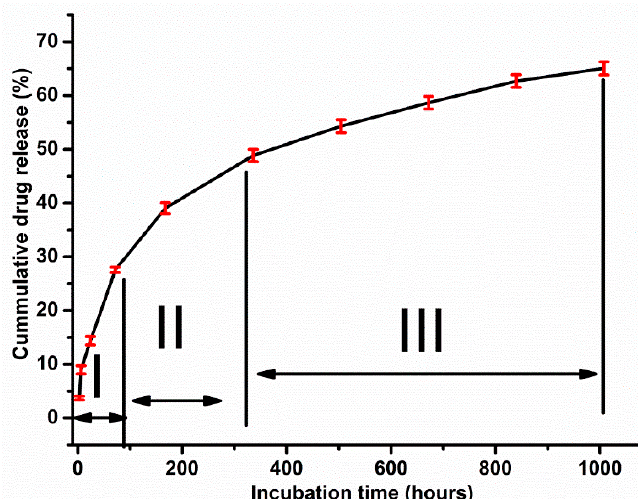
Figure 10. Cumulative release of curcumin in phosphate-buffered saline (PBS) from EPD coatings of chitosan/curcumin deposited on PEEK/BG/h-BN layers, showing 3 release stages: I, II and III. (The error bars indicate (±) standard deviation for three individual experiments, and each experiment contains 10 samples, n = 30).